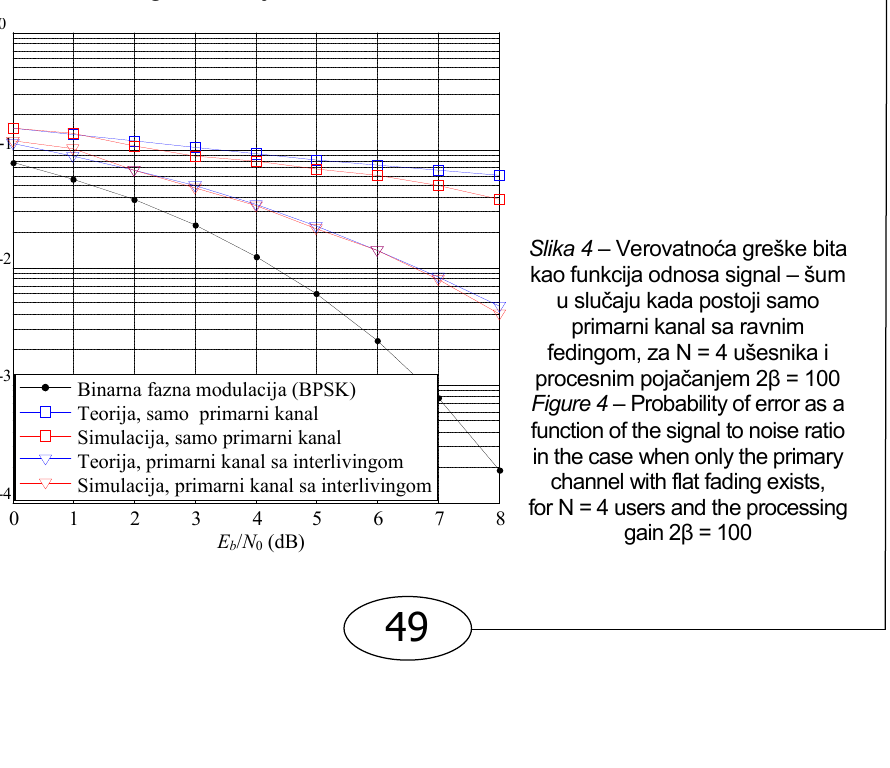
Figure 4 – Probability of error as a function of the signal to noise ratio in the case when only the primary channel with flat fading exists, for N = 4 users and the processing gain 2 β =